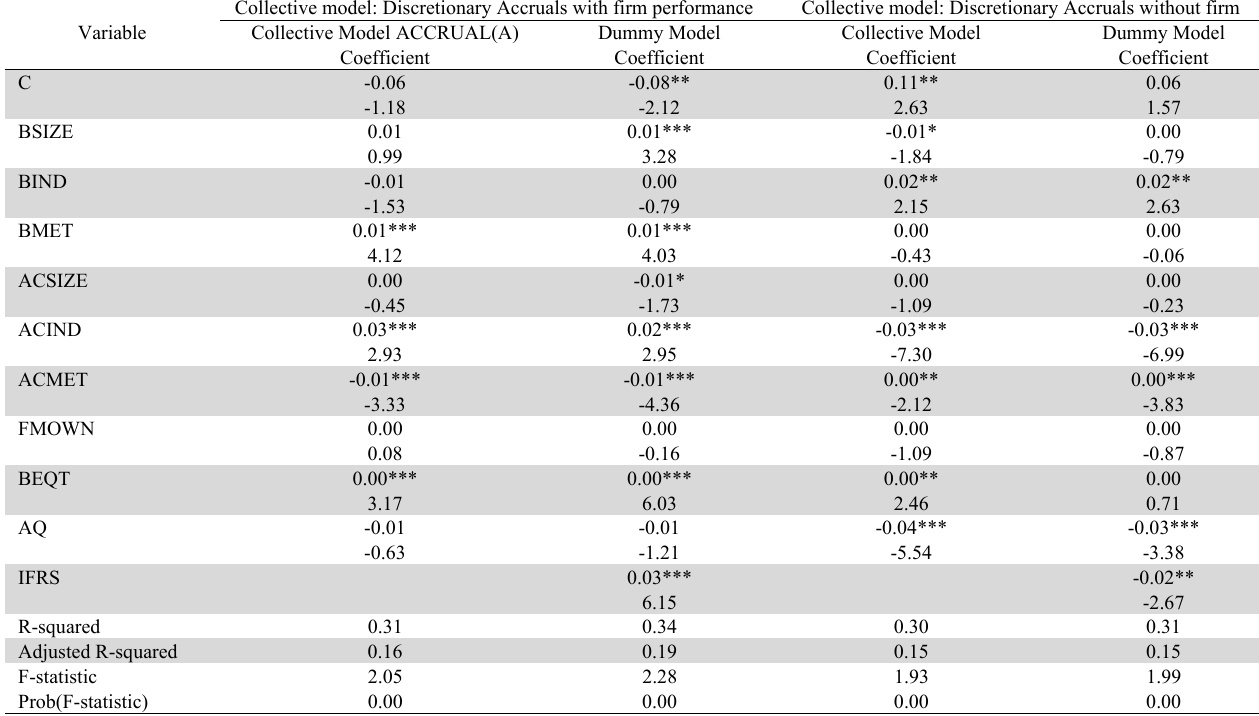
Regression Analysis of the Impact of CG and IFRS on Earning Management Collective model: Discretionary Accruals with firm performance Collective model: Discretionary Accruals without firm Variable Collective Model ACCRUAL(A) Dummy